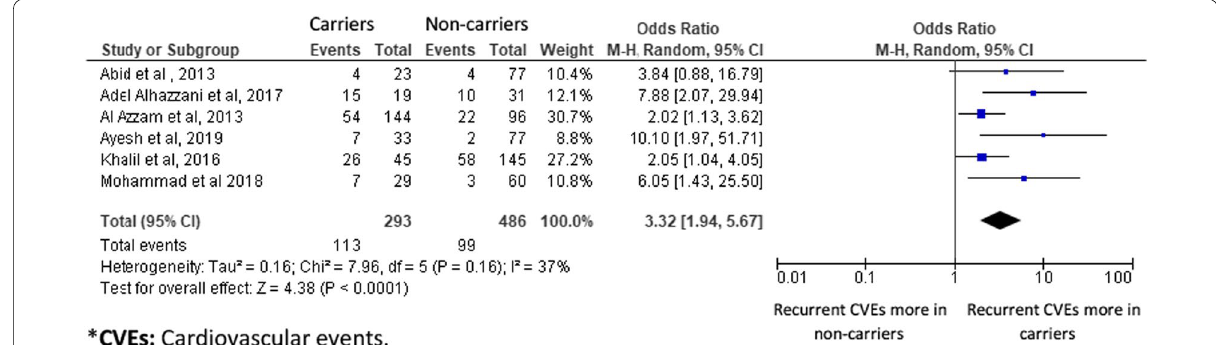
Fig. 2 Forest plot showing the frequency of recurrent CVEs among carriers and non-carriers of CYP2C19*2 mutation, and results of odds ratios